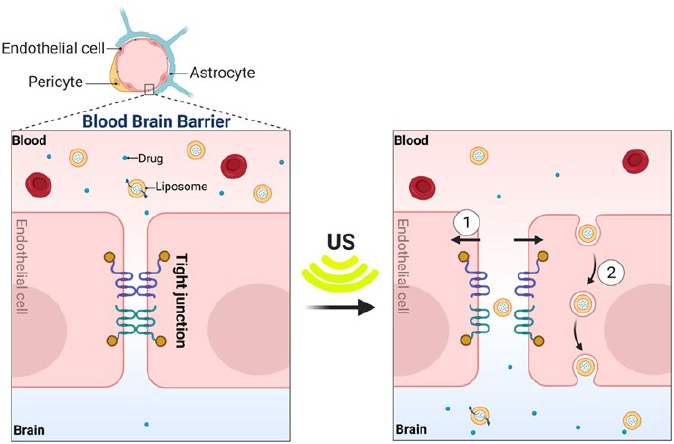
Figure 4. Mechanisms of therapeutic agent extravasation by conformational changes in blood vessels during microbubble (MB) cavitation, including transient disruption through stable cavitation and destructive opening through inertial cavitation. ( A ) The MB diameter changes when exposed to the pressure waves of ultrasound. At lower ultrasound intensities, MBs may undergo slight oscillations in size (stable cavitation). During the compression portion of the wave, the MB diameter shrinks, while during rarefaction the MB expands. At higher ultrasound intensities, the MB undergoes an unstable growth (inertial cavitation) followed by a rapid collapse and implosion. ( B ) Impact of ultrasound-induced cavitation on cell membrane permeability. (1) represents the vascular endothelium before ultrasound exposure as a significant barrier to the extravasation of circulating therapeutic agents. (2) shows MB expansion and microstreaming which lead to a temporary increase in the gap–junction distance between vascular endothelial cells, thus allowing circulating agents to extravasate. (3) represents MB compression. (4) MB bursting induced by inertial cavitation, resulting in microjets and shockwaves in the surrounding blood that can fragment nearby lipid membranes. Permission for adaptation of Panel A from [126] granted under Creative Commons Attribution 4.0 License, (http://creativecommons.org/licenses/by/4.0/; accessed on 15 August 2022), otherwise created with BioRender.com.